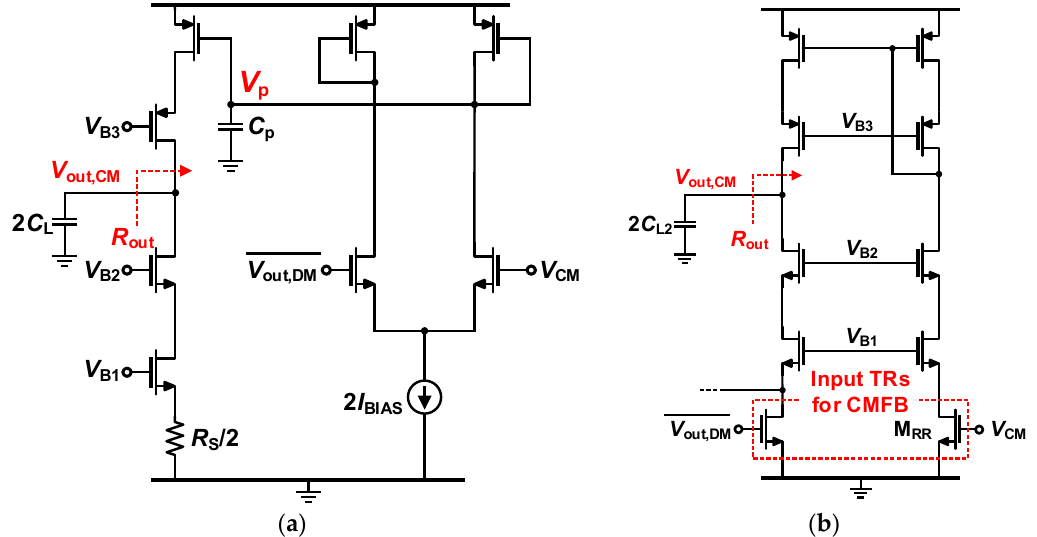
Figure 3. Simplified CMFB circuits for common mode (CM) control. ( a ) Conventional differential difference amplifier (DDA)-based CMFB; ( b ) Proposed CMFB.